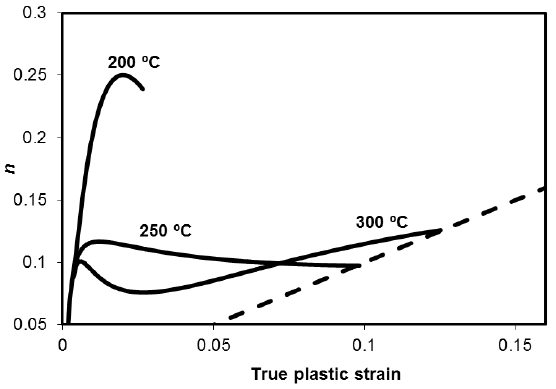
Figure 6. Evolution of the incremental work-hardening exponent, n , as a function of the true plastic strain, of three nanobainitic structures treated from the same steel treated at three different temperatures, 200, 250, and 300 °C. Adapted from reference [57].